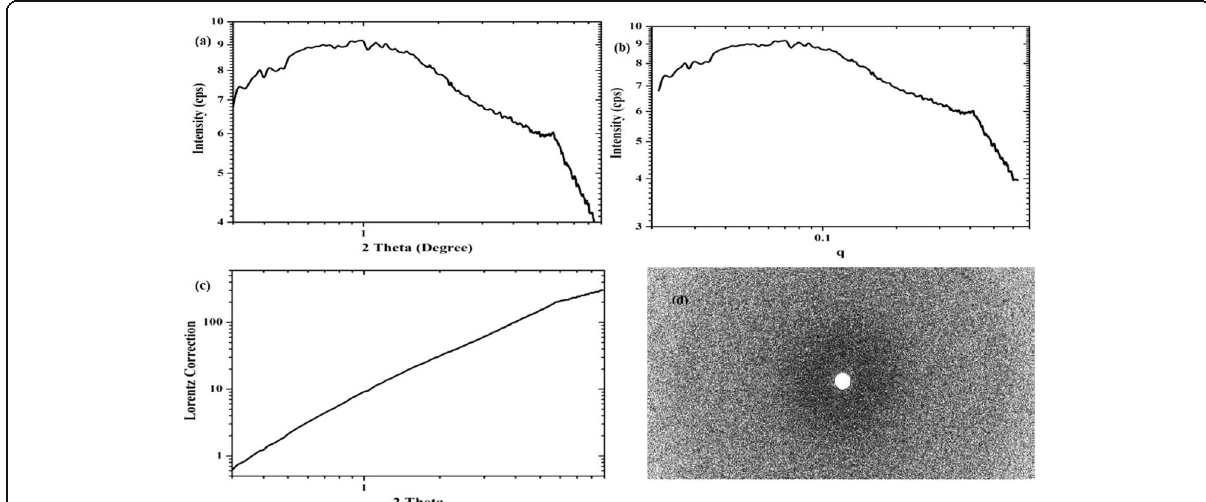
Fig. 3 Small angle X-ray scattering profile of placebo liposome. a Intensity vs. 2 theta. b Intensity vs. q . c Lorentz correction. d 2D small-angle X- ray scattering